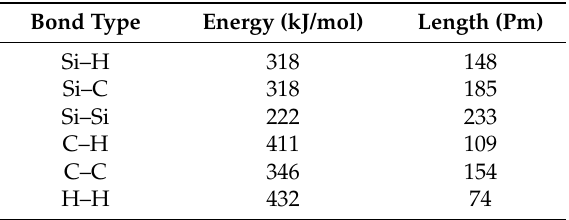
Table 3. The parameters of chemical